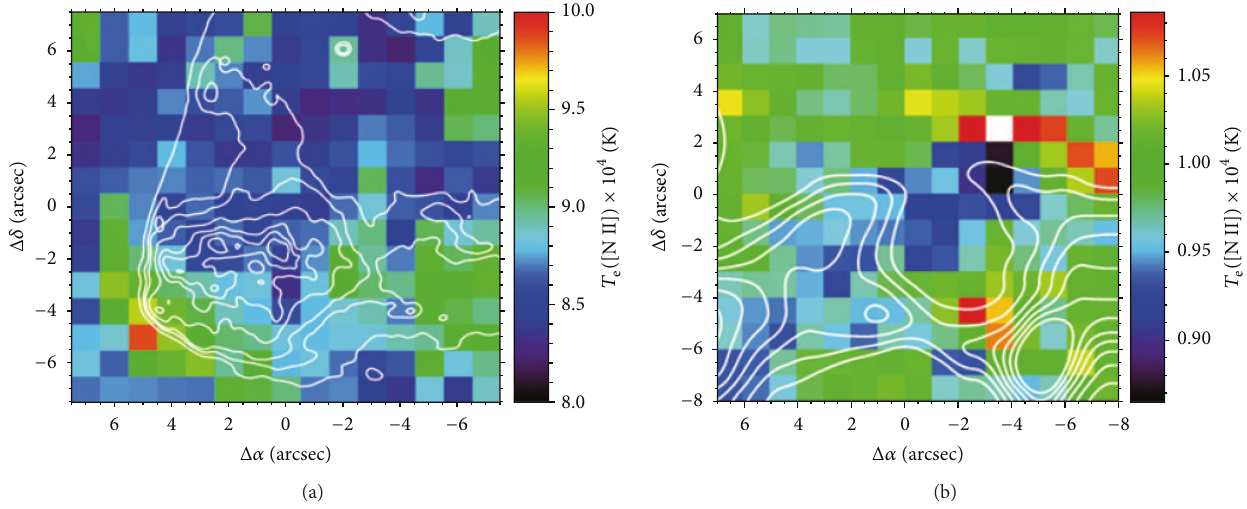
Figure 4: Spatial distribution maps of 𝑇 ([N II]) with H 𝛼 contours overplotted for (a) HH204 and (b) HH202, adapted from [53, 54], e arcs are located along the narrow areas at the leading working surfaces of the gas flows: at the lower-left corner for respectively. High- 𝑇 e enhancement that might be associated to a small high- 𝑇 HH204 and near the upper-right corner in HH202. An 𝑇 e HH202-S